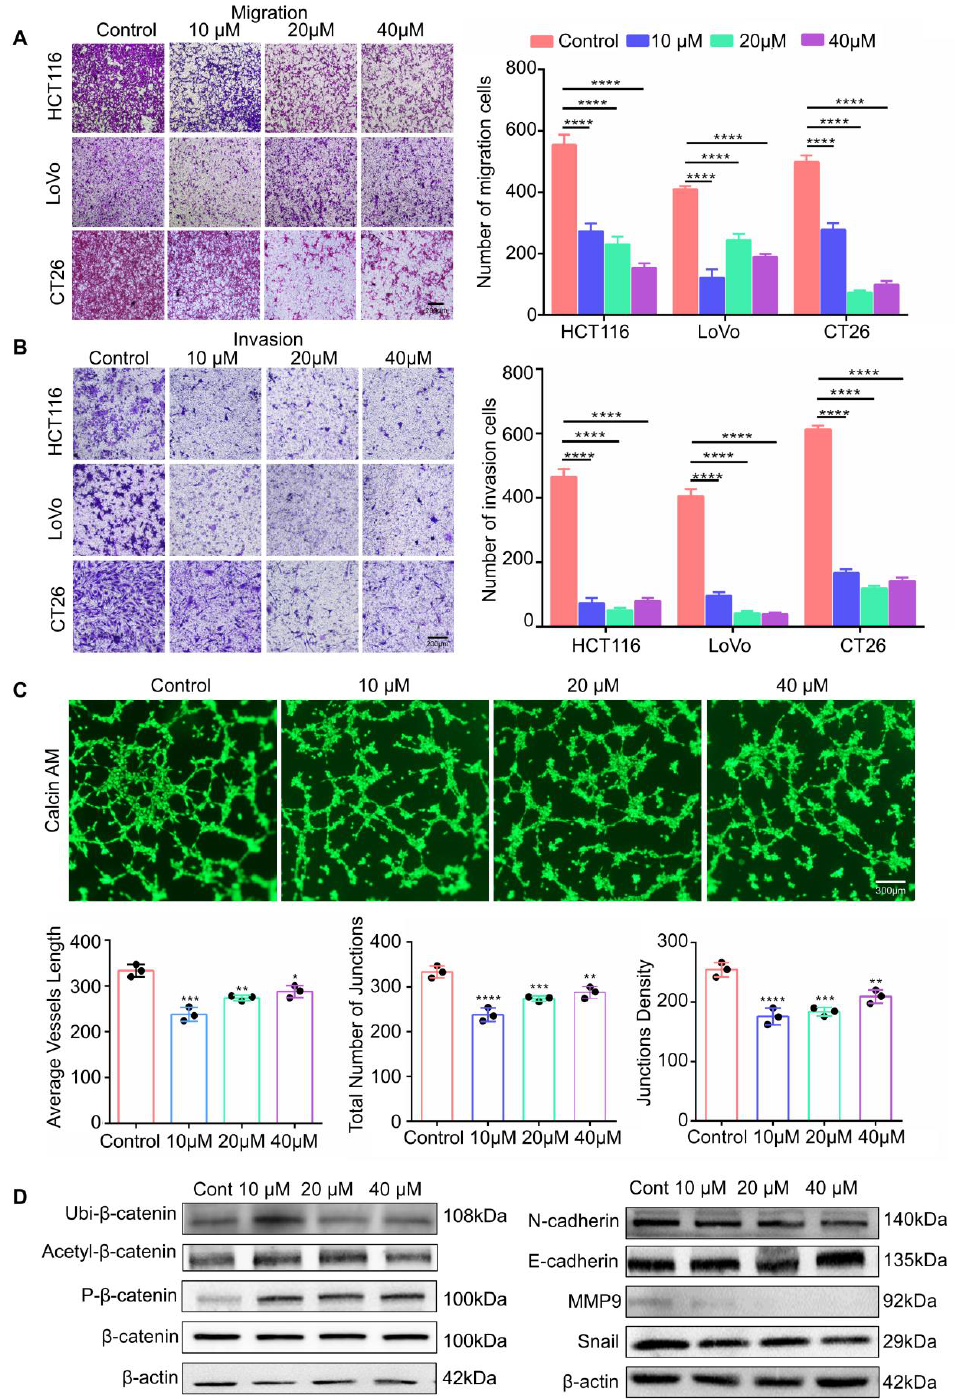
Figure 4. RP4 inhibits invasion and migration of CRC cells and blocks angiogenesis of HUVECs. ( A , B ), The migration and invasion assays of HCT116, LoVo, and CT26 cells after RP4 treatment. The migration and invasion of cells were quantified by counting the number of migrating or invasive cells in five randomly chosen fields. ( C ), Tube formation activity of HUVECs cultured in varying concentrations of RP4. Tube formation abilities were measured via the average vessels length, total number of junctions, and junction density. ( D ), Western blot results of CRC cells treated with RP4. Data are expressed as mean ± S.D. Statistical analysis was performed with one-way ANOVA ( n = 3; * p < 0.05, ** p < 0.01, *** p < 0.001, **** p < 0.0001). Representative images from three independent experiments are